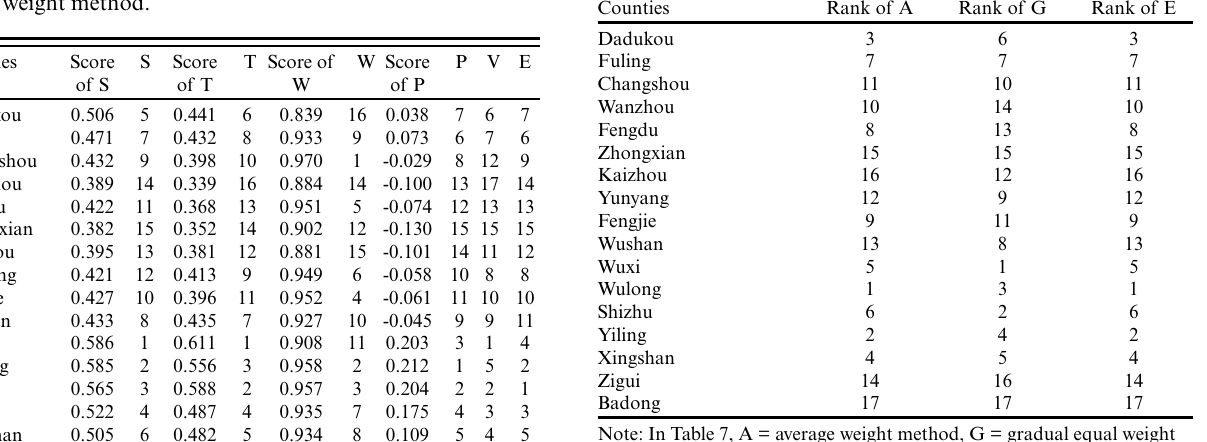
Table 5 . Disaster resilience ranking calculated using the gradual equal weight method.